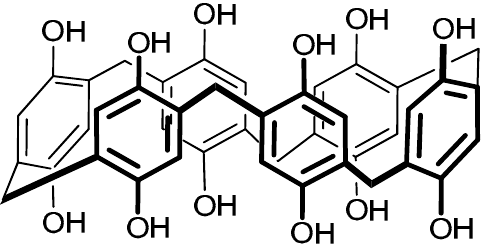
Figure 1. Chemical structure of P[6]A used in the investigation.